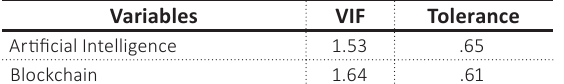
Table 5. Path analysis to employ networks